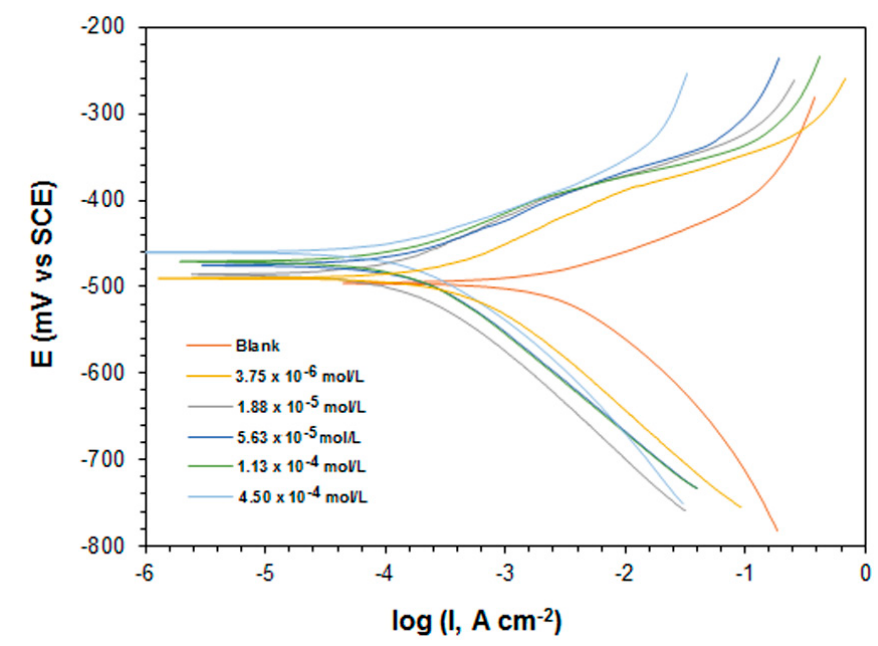
Figure 6. Tafel plots for mild steel in 1 M HCl solution without and with corrosion inhibitor 7 at 333